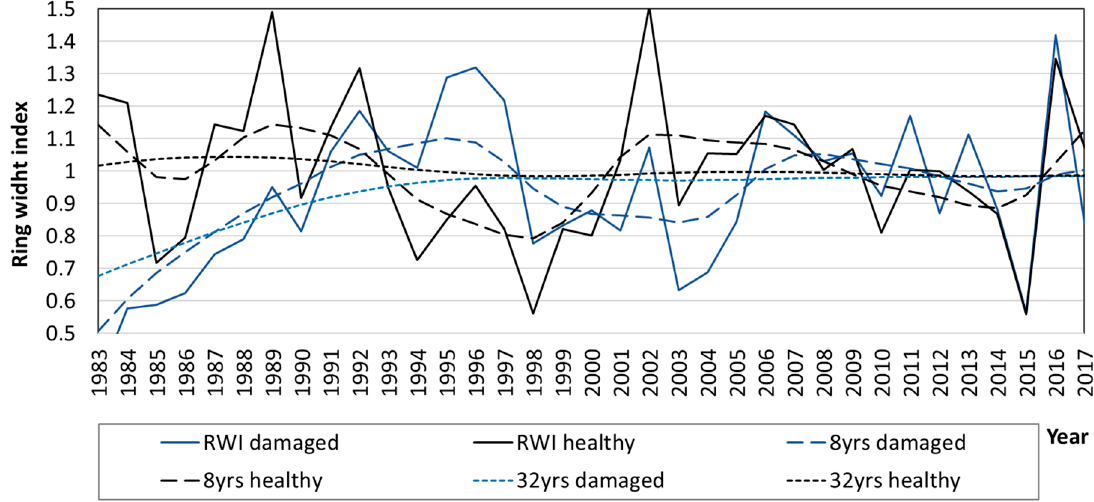
Figure 4. Standardized annual tree-ring increments of Norway spruce after removing the age trend (ring width index) and relevant smoothing splines (8- and 32-year spline).